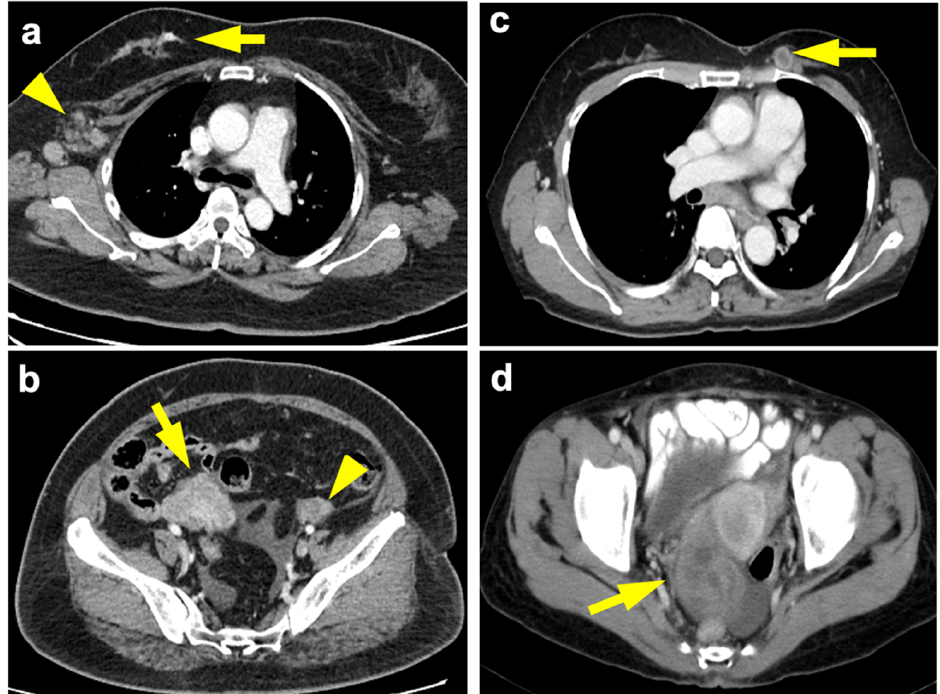
Figure 2. ( a ) 54-year-old woman, breast invasive lobular carcinoma (T3N2aM1) with ovarian metas- tasis. Contrast-enhanced axial chest CT shows infiltrative tumor at the upper outer and upper inner quadrant of the right breast (arrow) with right axillary nodal metastases (arrowhead). ( b ) Contrast- enhanced axial pelvic CT done at the same time showed a 5.9-cm solid tumor involving the right ovary (arrow) and a normal left ovary (arrowhead), based on final pathology. Immunohistochemistry of the breast tumor exhibited ER+, PR+ and HER2 − . The levels of CA125, CA15-3, CA19-9 and CEA at documented metastasis were 38.4 U/mL, 15.4 U/mL, 21.4 U/mL, and 0.84 ng/mL, respectively. ( c ) 55-year-old woman, ovarian serous adenocarcinoma (T3cN1M1) with breast metastasis. Contrast- enhanced axial chest CT shows necrotic tumors at upper inner quadrant of the left breast (arrow). ( d ) Contrast-enhanced axial pelvic CT 27 months ago showed complex cystic tumors (right 6.0 cm, left 2.2 cm) involving the ovaries (arrow). Immunohistochemistry of the breast tumor exhibited ER − , PR+, HER2+. The levels of CA125, CA15-3, CA19-9, and CEA at documented metastasis were 906.7 U/mL, 161.8 U/mL, 65.18 U/mL, 1.3 ng/mL, respectively. Recurrence was found eight months after diagnosis of breast metastasis and patient died in 33